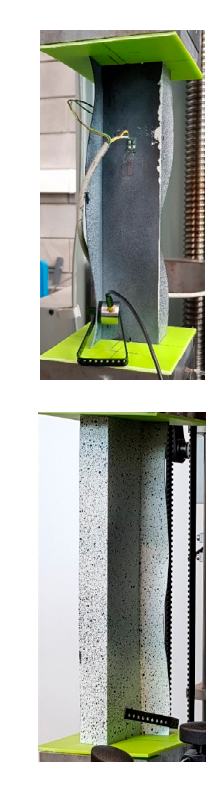
Figure 12. Column z_2—maps of the Tsai–Wu critical parameter and forms of post-critical deformation: ( a ) Test 1 and ( b ) Test 3.